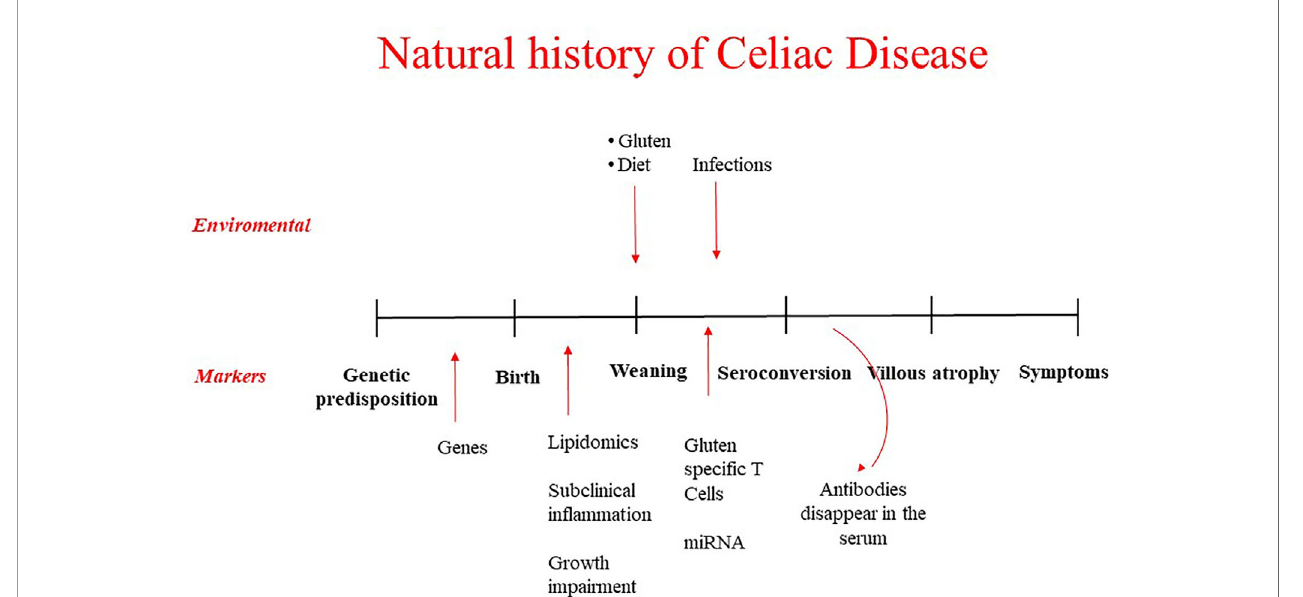
FIGURE 1 | Natural history of celiac disease: environmental factors possible target of prevention strategies and biomarkers to identify at risk